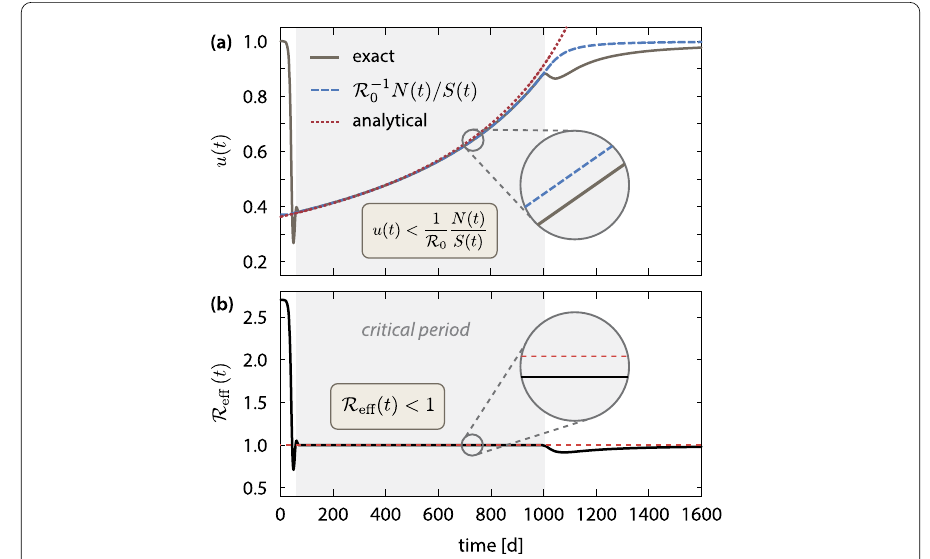
Figure 6 ( a ) Analysis of the optimal mean contact reduction u ( t ) during the critical period, where the number of simultaneously infected must be kept constant (the plot is for C 0 = 10,000). The numerically exact result is plotted along with the stability boundary R –1 0 N ( t )/ S ( t ) (blue dashed line) and the analytical approximation (13) (red dotted line). The inset shows that the optimal control respects the stability requirement (14) during the critical period. ( b ) Plot of effective reproduction number R eff ( t ) corresponding to the optimal control. Throughout the critical period, R eff ( t ) is kept slightly below